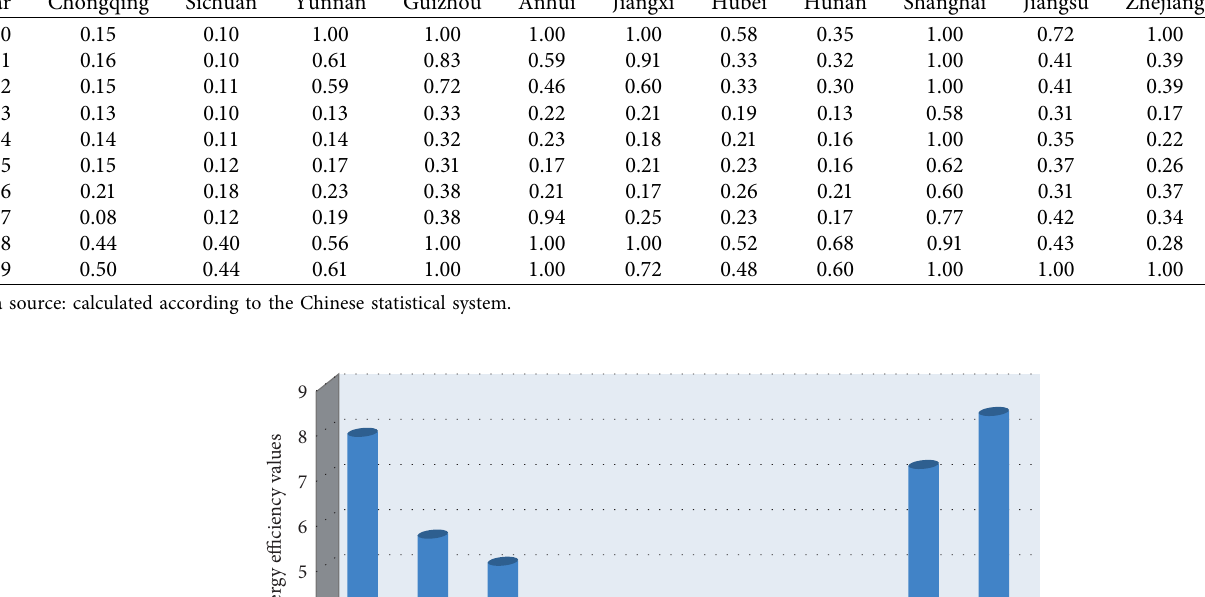
Table 3: Logistics energy efficiency of the provinces and cities in the Yangtze River Economic Belt. Year